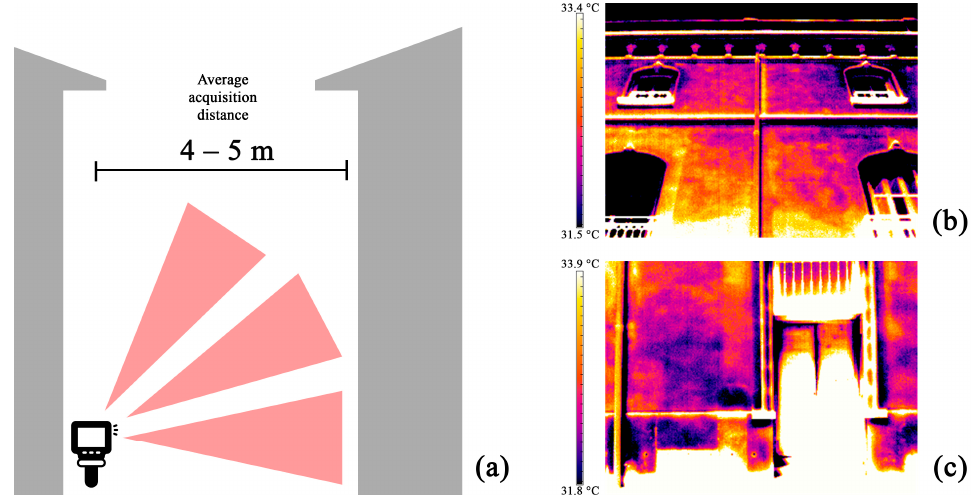
Figure 5. ( a ) TIR image acquisition scheme; ( b ) example of a thermal image acquired, of the upper area of the façade, and, therefore, characterised by a high perspective distortion; ( c ) example of a thermal image acquired, corresponding to the first floor of the building, covering only a limited portion of the façade.